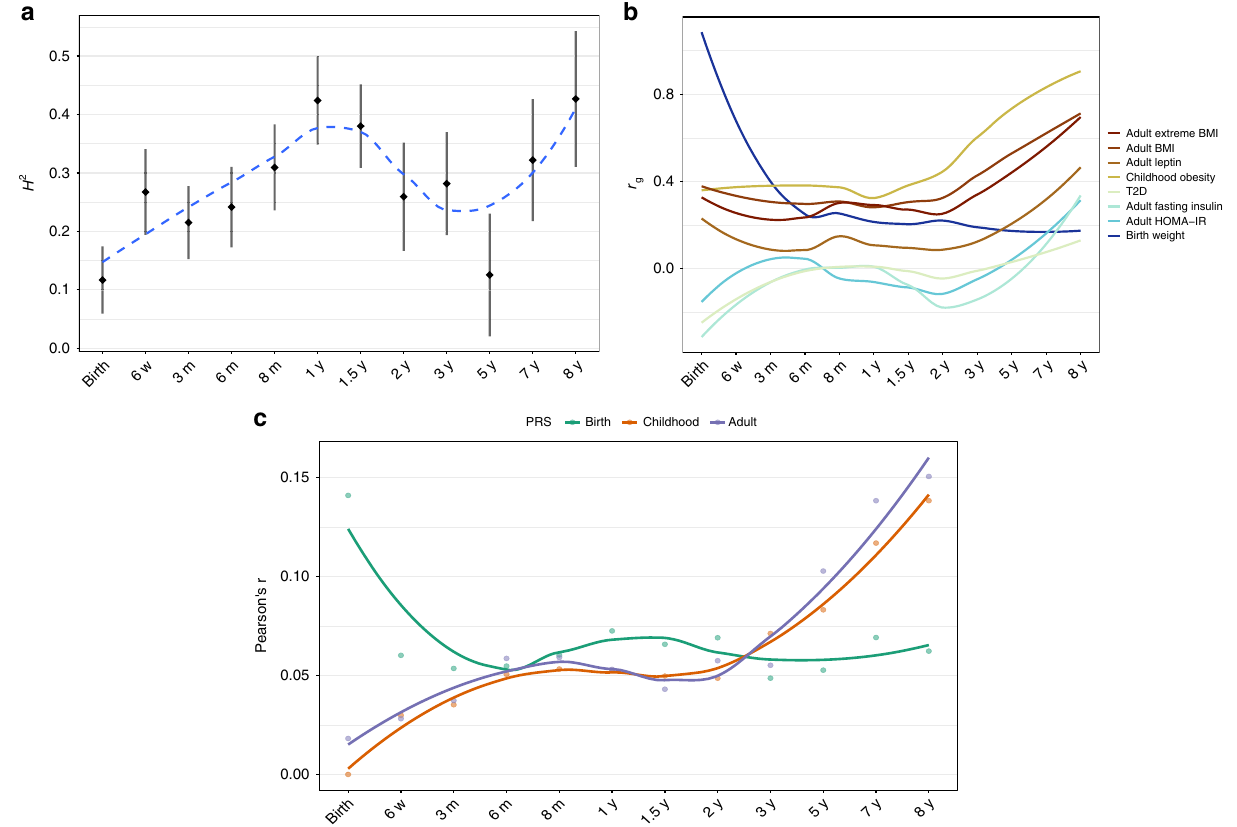
Fig. 7 Evolution of heritability, correlation with other traits, and risk scores at all time points. a H 2 estimates based on LD score regression for BMI plotted at each time point (black) along with locally estimated scatterplot smoothing (LOESS) local regression (in blue). Error bars represent one SEM on each side of the point. b LOESS local regression of the LD score regression coef fi cient ( r g ) between the BMI association results at each time point and phenotypes from LD Hub (i) adult extreme BMI, (ii) adult BMI, (iii) leptin not adjusted for BMI, (iv) childhood obesity, (v) type 2 diabetes, T2D, (vi) fasting insulin